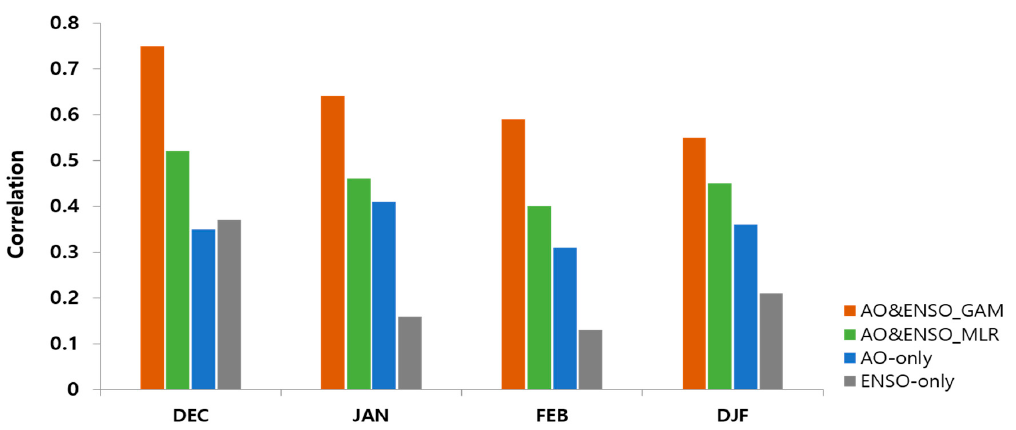
Figure 9. Correlations between observational SAT in South Korea and reconstruction of GAM (orange bar) and MLR (green bar) based on both AO and ENSO (blue bar) for the winter season. Correlation skill of SAT regressed on AO-only (blue bar) and ENSO-only (gray bar).